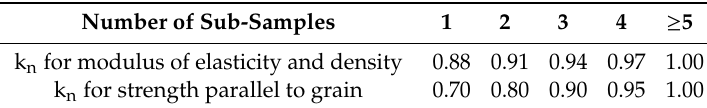
Table 2. Factor for adjusting the results of the tests by the number of sub-samples.